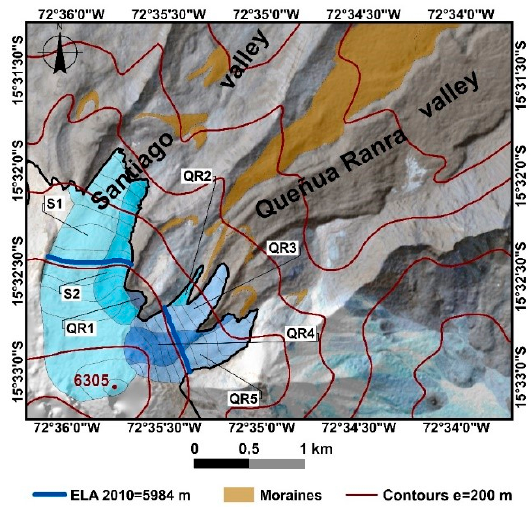
Figure 8. Glaciers and current moraines mapped in the headwaters of the Santiago and Queñua Ranra Valleys. The bluish ‐ shades polygons are the different ice tongues and the black line is the glacier system limit at 2010.